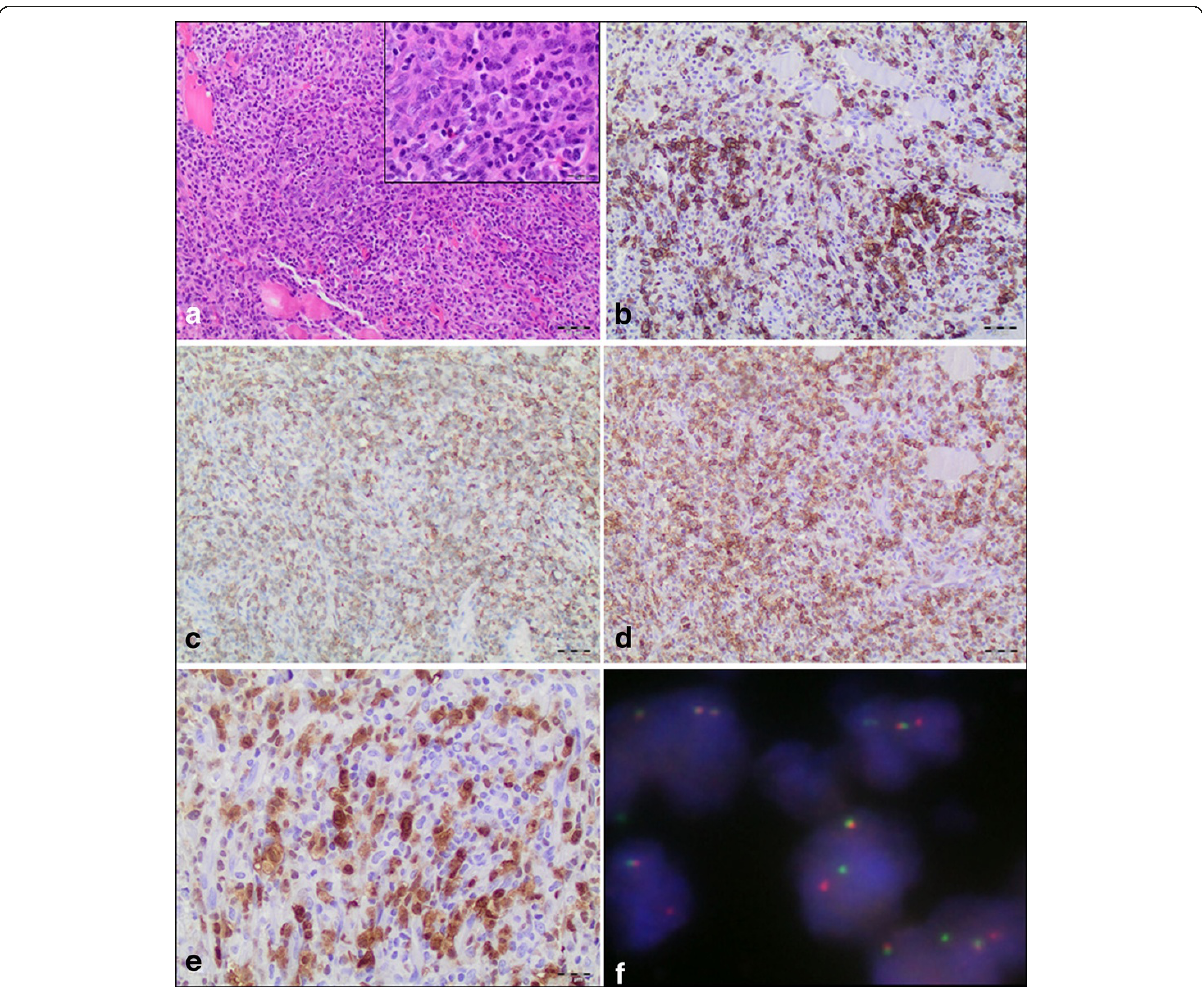
Figure 2 Histological features and immunophenotype of the intramuscular ALCL . (A) The biceps femoris muscle showed a tumoral and diffuse polymorphic infiltration by large lymphoid cells (magnification 100×). Inlay: Majority of the cells were small to middle sized with pleomorphic nuclei and various size of pale cytoplasm. Intermingled and less common larger cells with eccentric lobulated “ horse shoe ” or “ kidney-shape ” nuclei and an abundant cytoplasm (so called “ hallmark cells ” ) (magnification 400×). (B) Strong membranous and perinuclear dot- like positivity for CD30 (magnification 100×). (C) T-cell phenotype of ALCL demonstrated by positivity for CD7 and CD8 (D) (magnification 100×). (E) Tumor cells expressing ALK-1 protein both in the cytoplasm and nucleus indicating the classical t(2;5) translocation (magnification 200×). (F) FISH with ALK Dual Color, Break Apart Rearrangement Probe for detecting translocations affecting 2p23 ALK breakpoint region. ALK locus in its native state is seen as two immediately adjacent red and green signals. However, if a t(2;5) chromosome rearrangement has occurred as in this case, one separate red and one separate green signals can be seen (the one remaining native ALK remains as an orange/green signal) (magnification